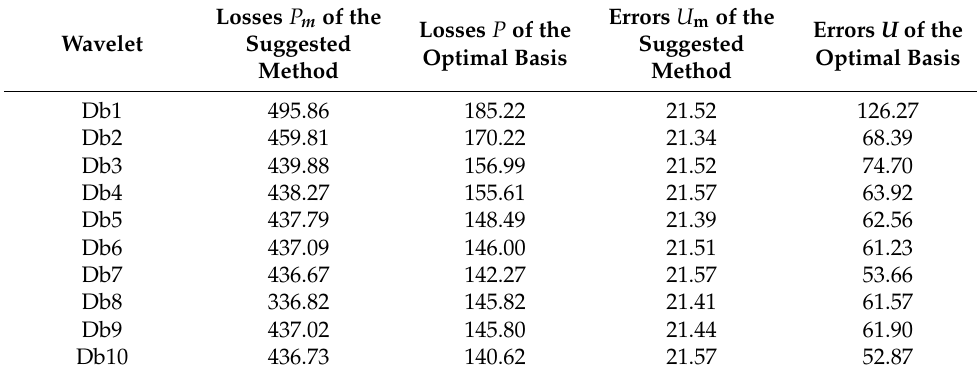
Table 2. Method efficiency estimate results, obtained from the data for March 2021. Losses P m of the Wavelet